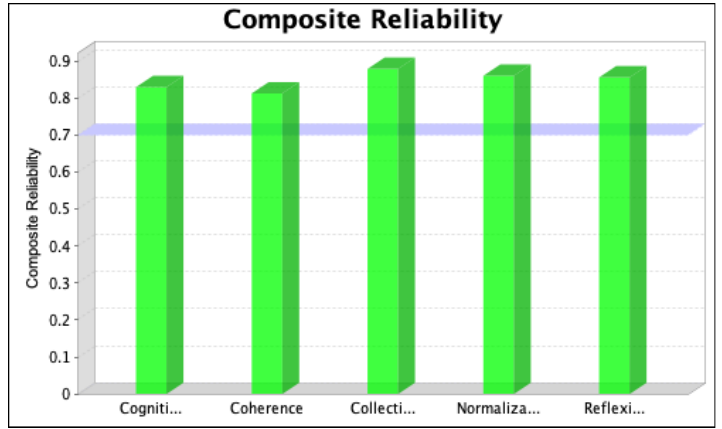
Figure 8. Values of composite reliability in the third iteration.